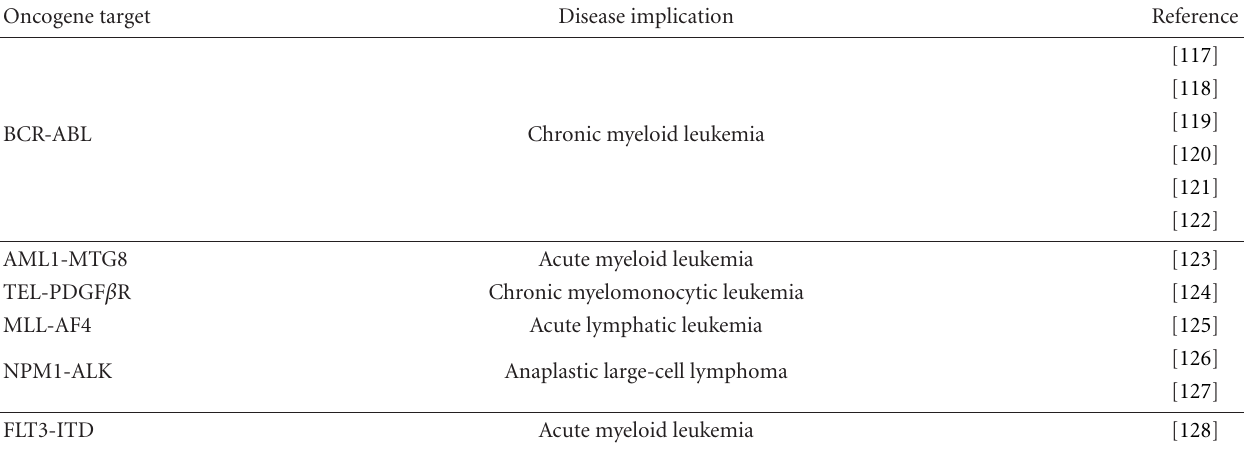
Table 1: RNAi targeting hematopoietic fusion